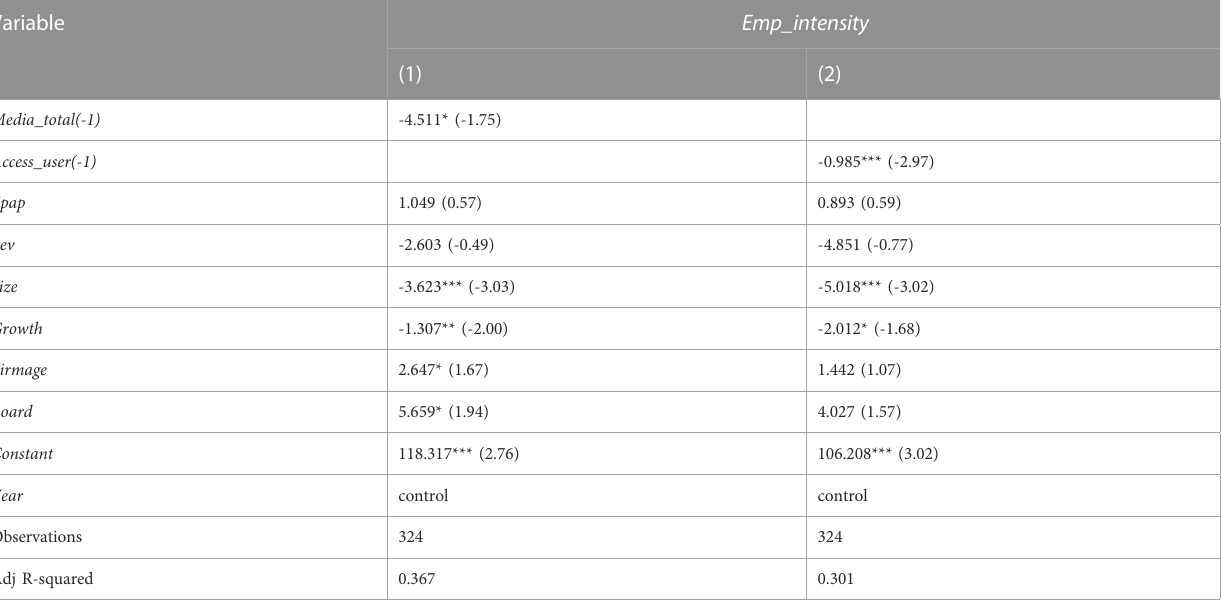
TABLE 4 Results of benchmark